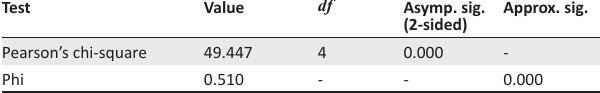
TABLE 9: Brainstorming versus step-by-step decision-making process. Test Value df Asymp. sig.